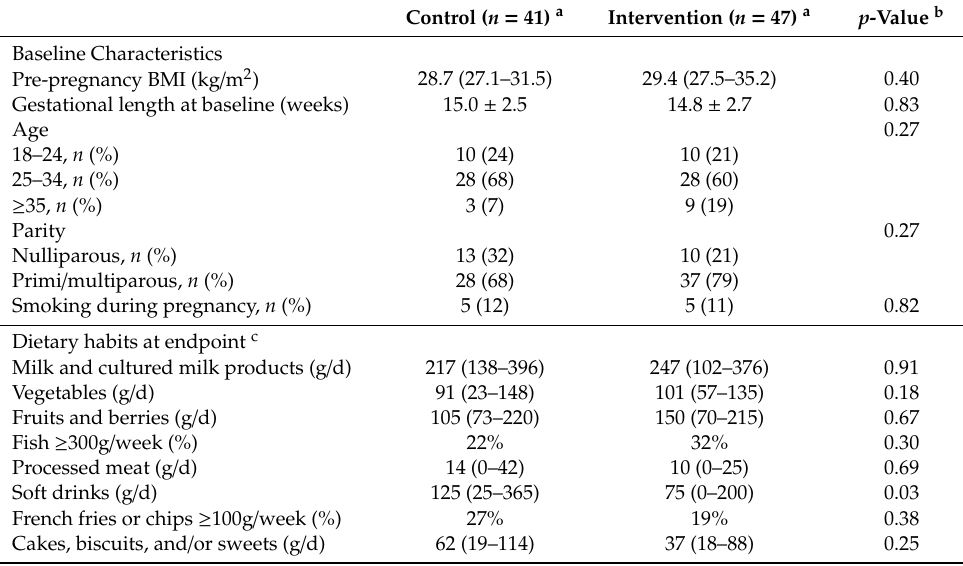
Table 4. Baseline characteristics and dietary habits at the endpoint among pregnant women participating in the pilot